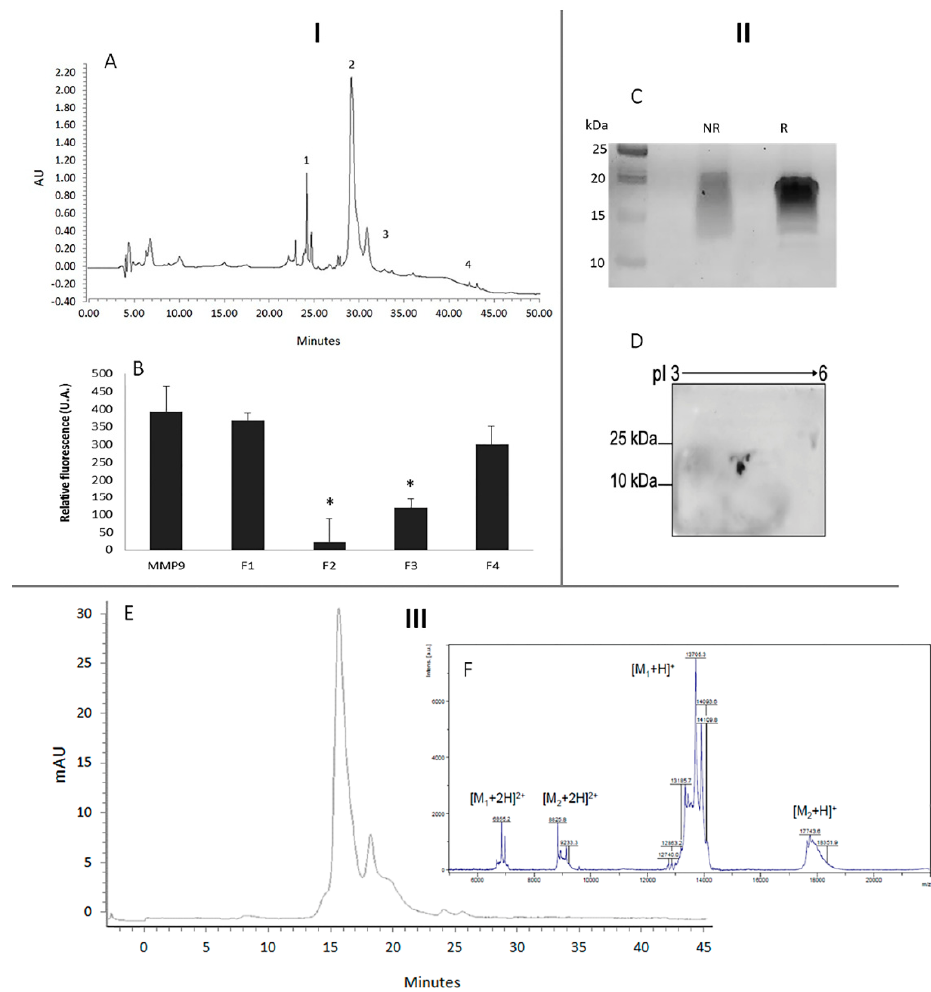
Figure 2. Characterization of the L. albus MMP-9 inhibitory protein. I: HPLC separation and peak purification of fraction 4 obtained by SEC (Figure 1A): ( A ) Reverse phase HPLC chromatographic profile of the MMP-9 inhibitory protein fraction 4 previously isolated from L. albus cotyledons by gel filtration. The main peaks obtained were collected as fractions 1 to 4. ( B ) MMP-9 proteolytic activity of fractions 1 to 4 in A, as quantified by the DQ-gelatin method. The results are expressed in arbitrary units of fluorescence and represent an average of three replicates ± SD. * p < 0.05. II: Electrophoretic analyses: ( C ) The polypeptide profile of fraction 2 in A was analyzed by denaturing electrophoresis performed under non-reducing (NR) and reducing (R) conditions. Representative image of the polypeptide composition of isolated MMPI from L. albus cotyledons separated by SDS- PAGE. ( D ) Two-dimensional electrophoretic separation of the isolated MMPI using 2D-GE IPG pH 3 to 6, 7 cm long, followed by SDS-PAGE 17.5% ( w / v ) acrylamide. III: Mass determination: ( E ) Size exclusion chromatography of the isolated MMPI (fraction 2 in A) performed under non-denaturing conditions, showing its mass. ( F ) Intact protein analysis of the isolated MMPI by MALDI TOF MS.